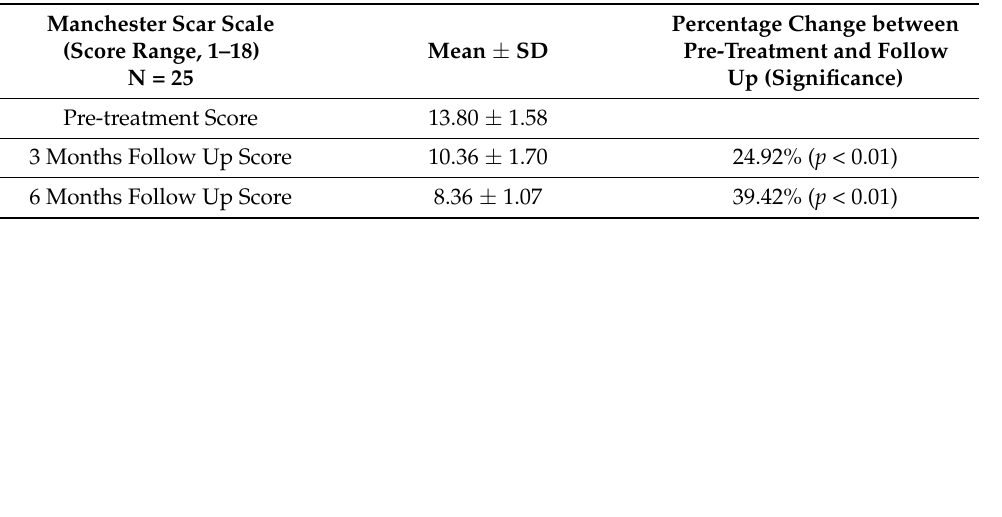
Figure 1. Histogram representation of the mean parameters scores of Manchester Scar Scale. Table 2. Total Manchester Scar Scale